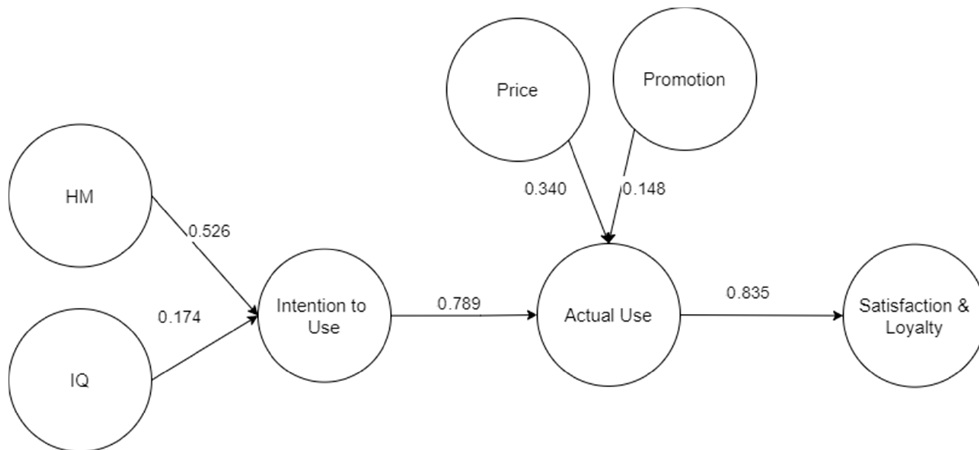
Figure 3. The final SEM to determine factors affecting customer satisfaction and loyalty in online food delivery service (OFDS) among Indonesians during the new normal of the COVID-19 pan- demic.